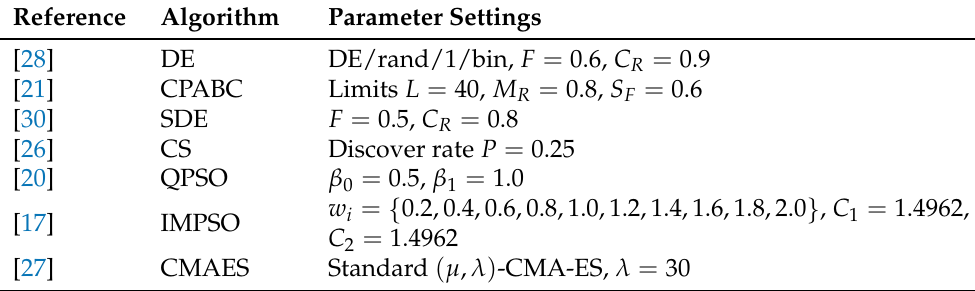
Table 3. Parameter settings in state-of-the-art literature